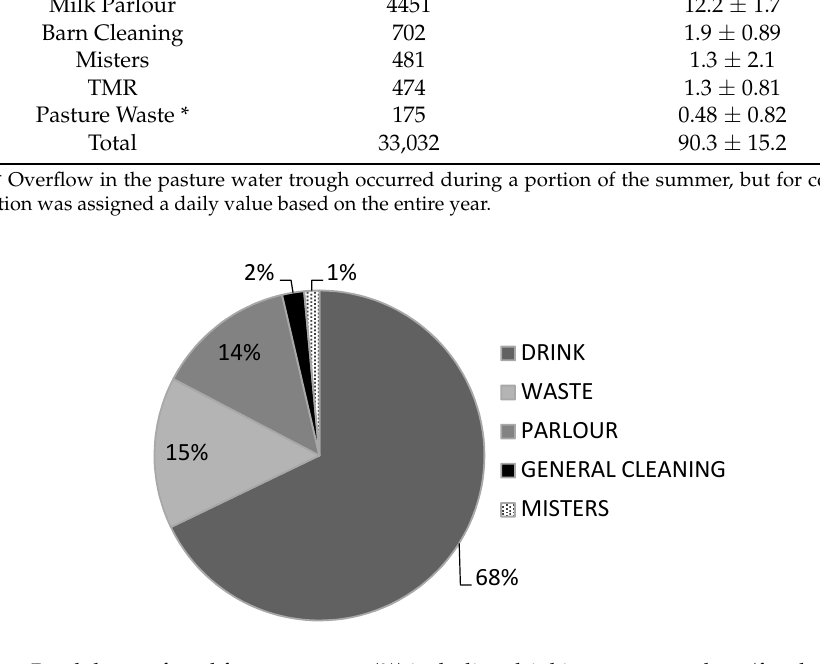
Figure 3. Breakdown of total farm water use (%) including drinking, waste, parlour (foot baths, parlour floor cleaning, cow cleaning, line sanitization), general cleaning (i.e., barn floor and farm equipment), and mister water use. Waste includes water that was not recovered from the plate cooler return